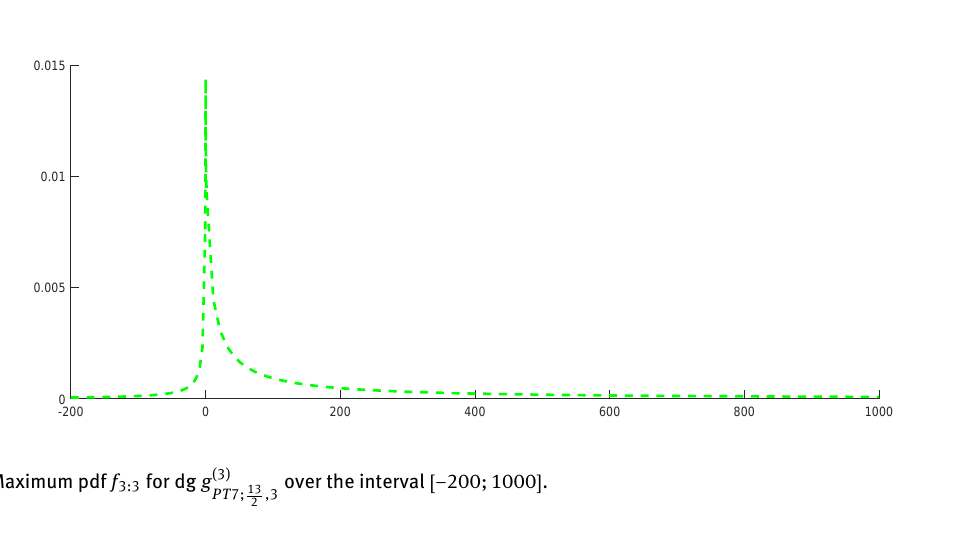
over the interval [−200;1000] PT 7; 13 2 ,3